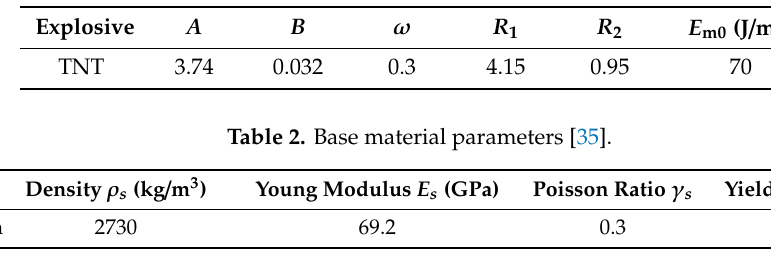
Table 1. JWL model parameters of the charge [30].